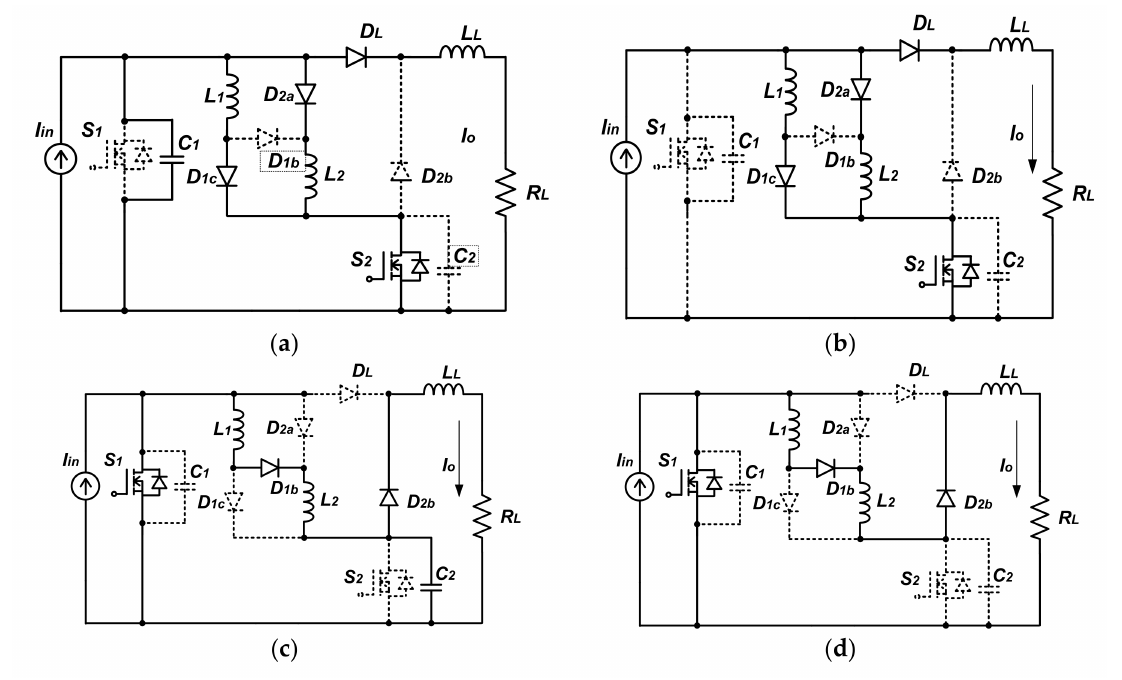
Figure 6. The operation stages of 1/3-type SDRSIC; ( a ) Stage 1, ( b ) Stage 1, ( c ) Stage 1 ( d ) Stage 4.